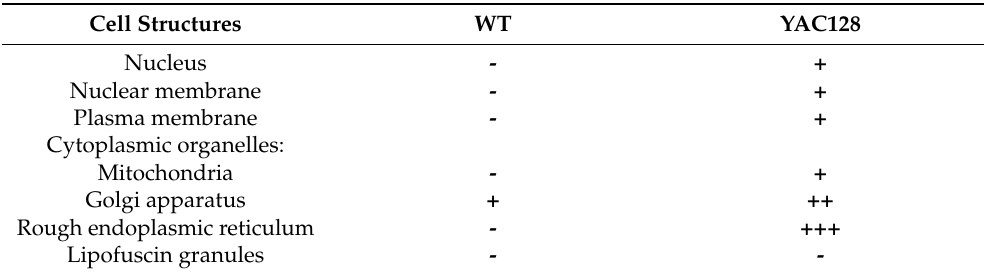
Table 1. Ultrastructural alterations were seen in DG granular neurons of WT and YAC128 mice in the late stage of HD. Cell Structures WT YAC128 Nucleus - + Nuclear membrane - + Plasma membrane - + Cytoplasmic organelles: Mitochondria - + Golgi apparatus + ++ Rough endoplasmic reticulum - +++ Lipofuscin granules